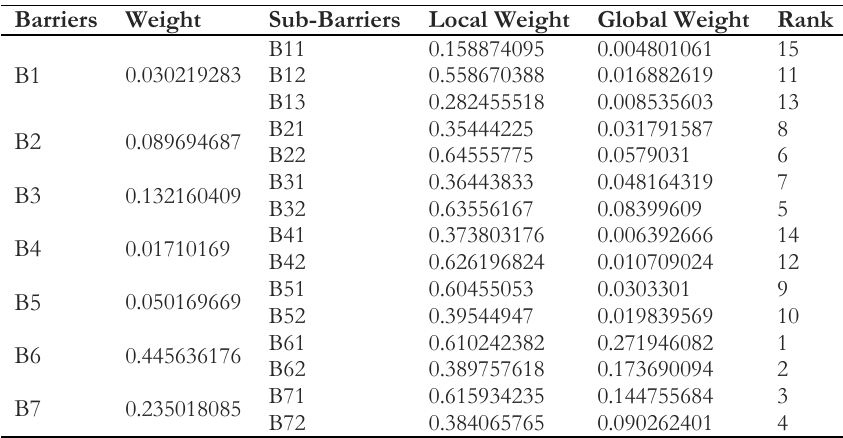
Table 8. Transformation barriers